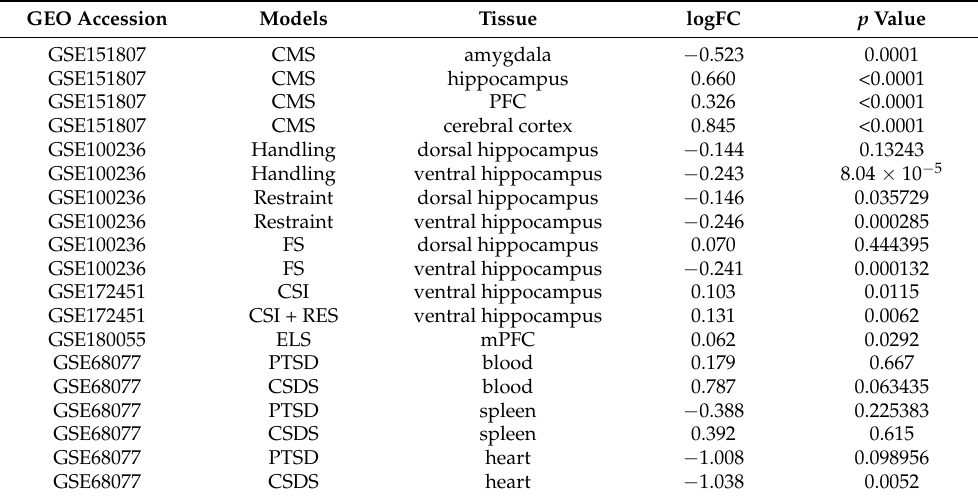
Table 4. The expression of TfR1 in different brain regions and tissues in various stressed animal models from GEO